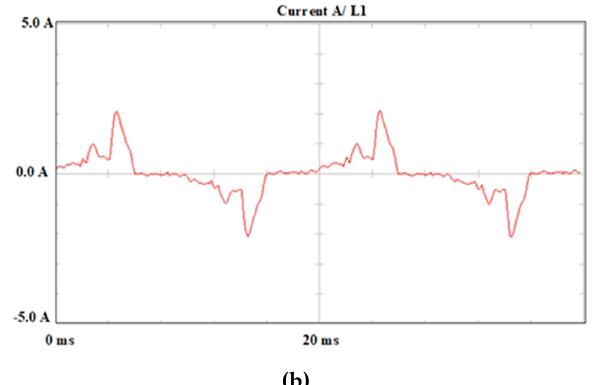
Figure 9. Set of office equipment: ( a ) input voltage waveform, ( b ) input current waveform.